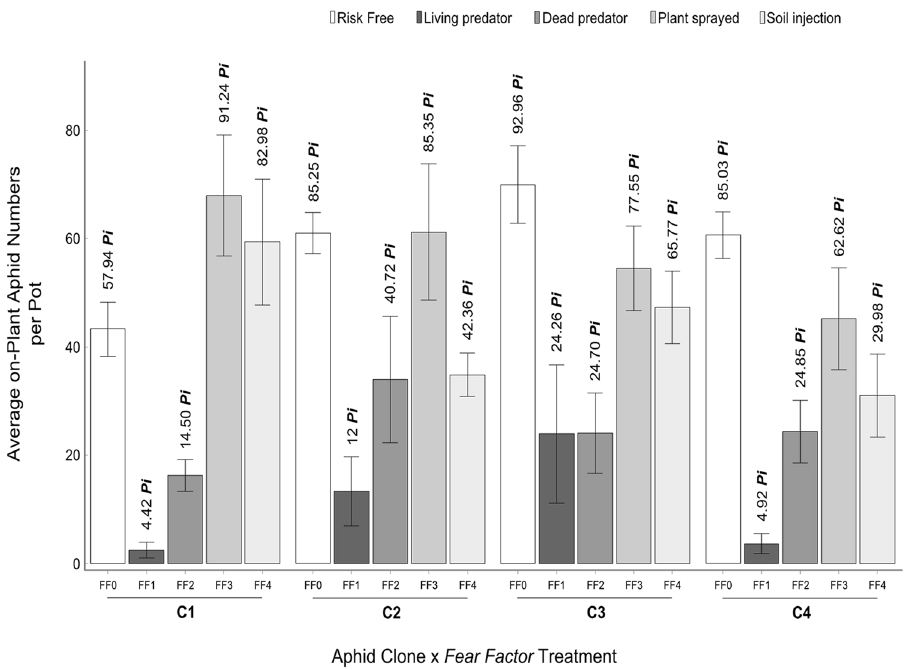
Figure 1. Aphid reproductive success. Average on-plant Myzus persicae’s total numbers per pot/enclosure (mean ± SE) are shown for the clones (C1–C4) across Fear Factor treatments. The bars are annotated with percentiles ( Pi ), which on the one hand relatively reflect the performance ranks (positions) of aphid reproductive success under different clone by Fear Factor combinations. On the other hand, the percentiles relatively denote the efficacy of the Fear Factor treatments in suppressing aphid reproductive success across aphid clones. Fear Factor levels are the absence of predation and predator cues (FF0 i.e . aphid alone, risk-free) and across the Fear Factor treatments [Living predator (FF1), dead tethered predator (FF2), shoot-sprayed cues (FF3), and soil-infused ones